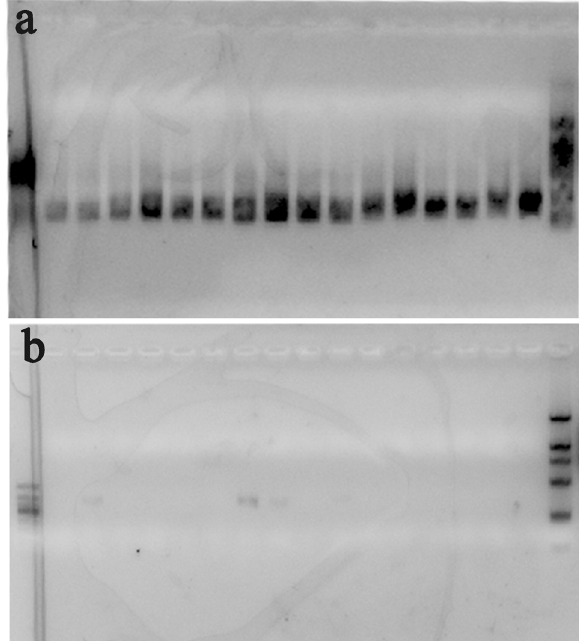
Figure 4. Agarose gel electrophoresis of PCR products based on the specific primers for bacteria (a) and fungi (b),